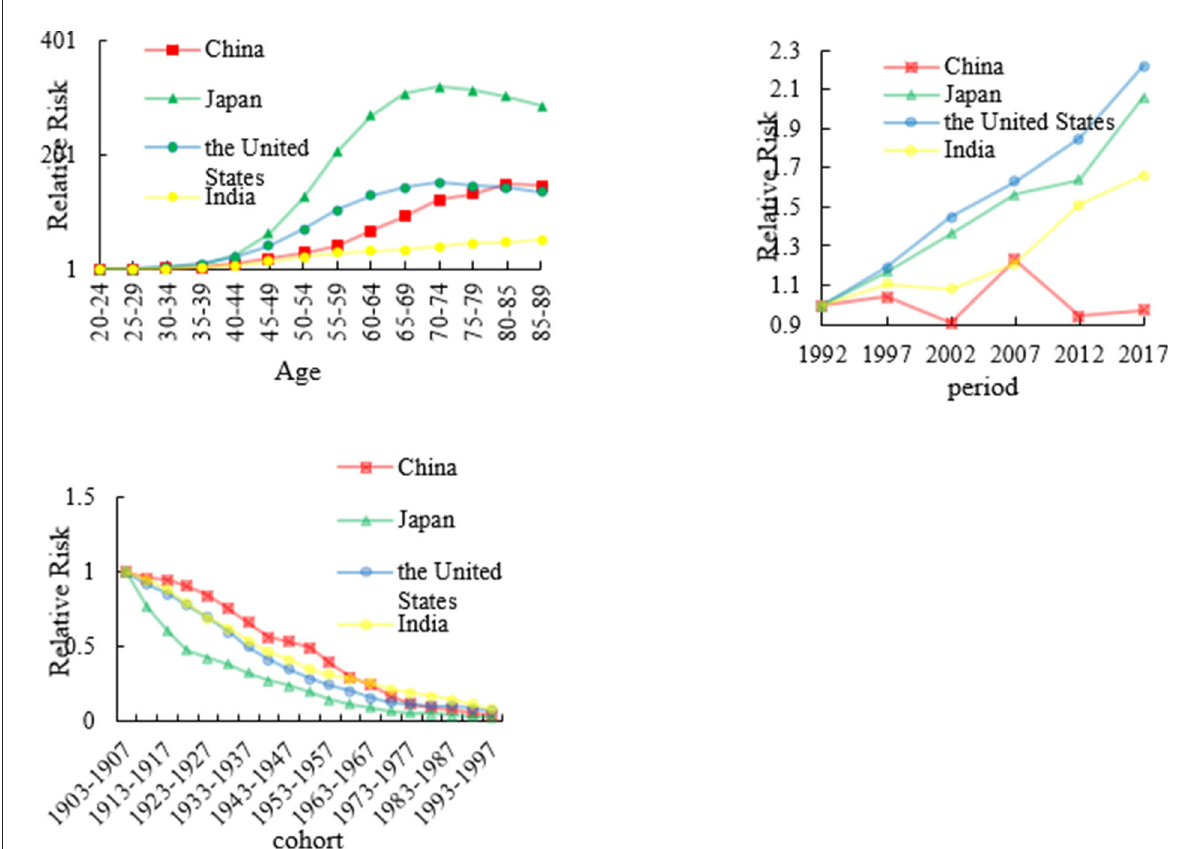
FIGURE3 The age, period, and cohort effects on esophageal cancer mortality across four